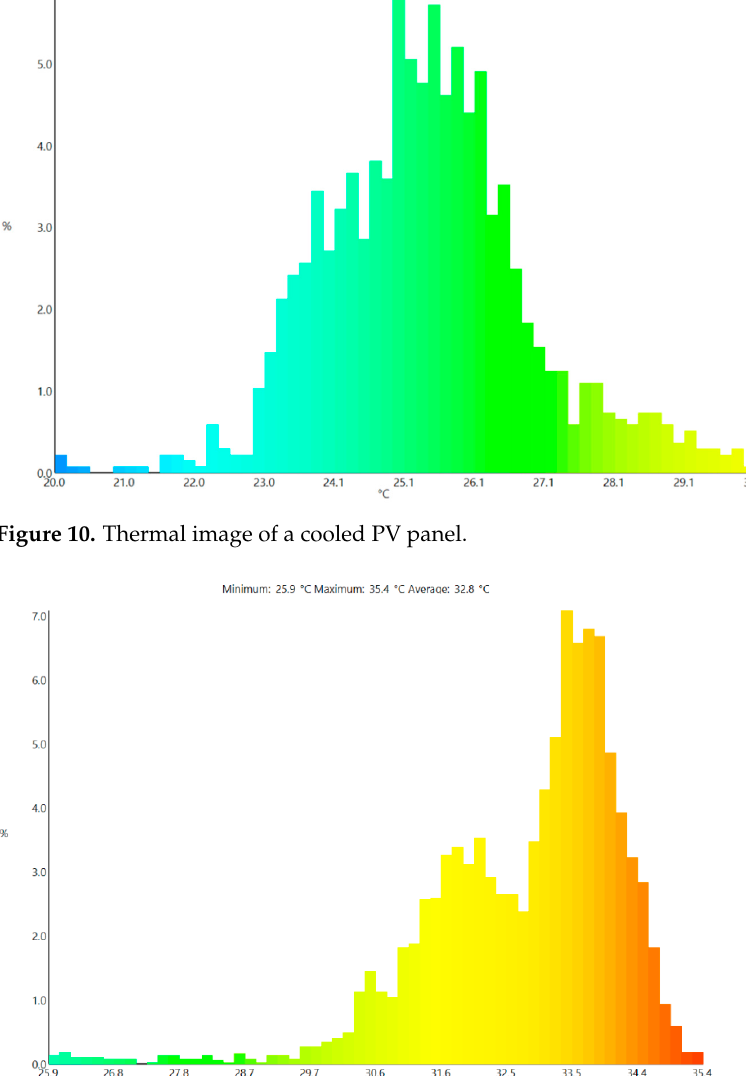
Figure 11. Thermal image of an uncooled PV panel.